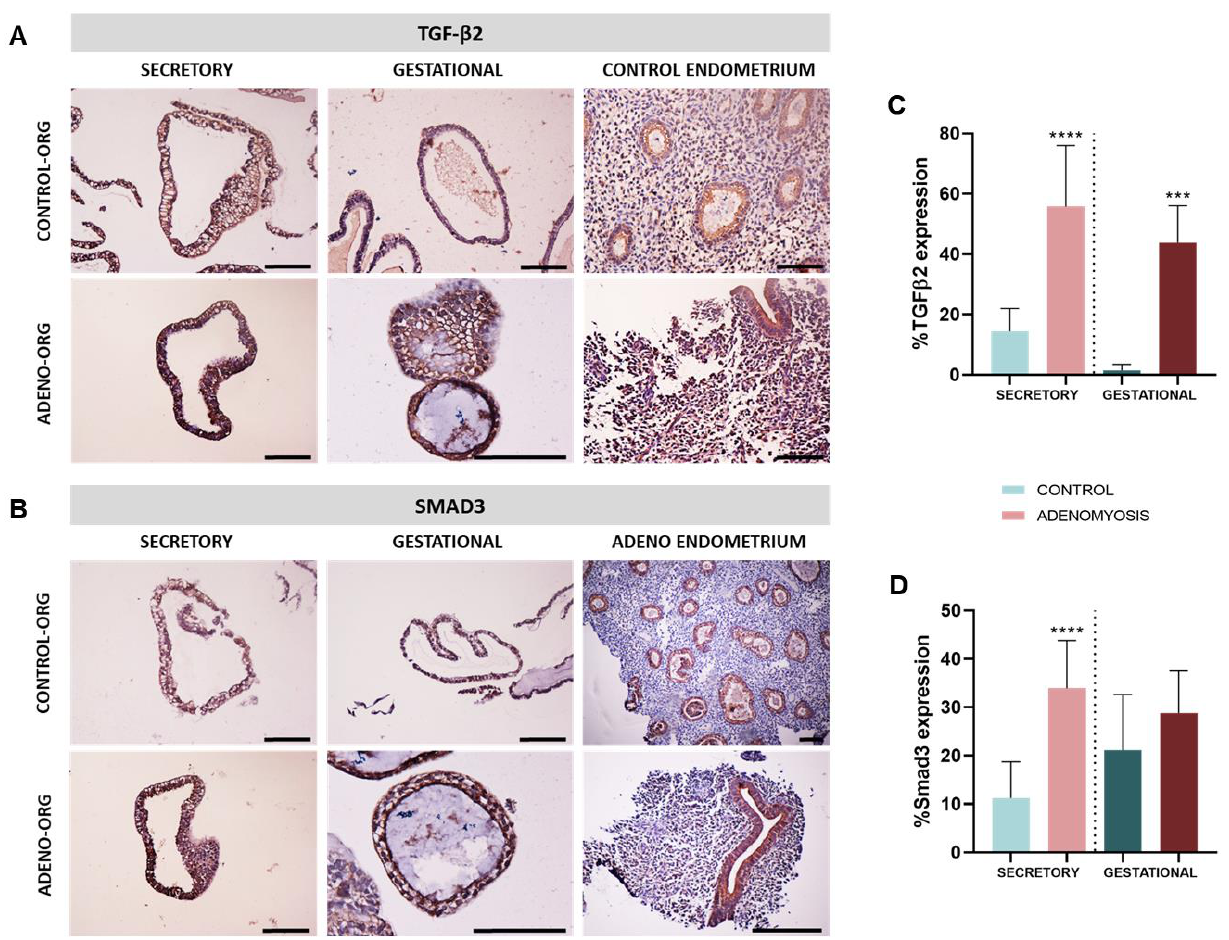
Figure 3. Pathological characterization of adenomyosis secretory and gestational organoids. Repre- sentative images of ( A ) TGF- β2 and ( B ) SMAD3 in Adeno and Control sec-organoids and gest-or- tative images of ( A ) TGF- β 2 and ( B ) SMAD3 in Adeno and Control sec-organoids and gest-organoids ganoids by IHC. Quantification of ( C ) TGF- β2 and ( D ) SMAD3 protein expression in Adeno and by IHC. Quantification of ( C ) TGF- β 2 and ( D ) SMAD3 protein expression in Adeno and Control Control sec-organoids and gest-organoids. *** p < 0.001, **** p < 0.0001. sec-organoids and gest-organoids. *** p < 0.001, **** p <